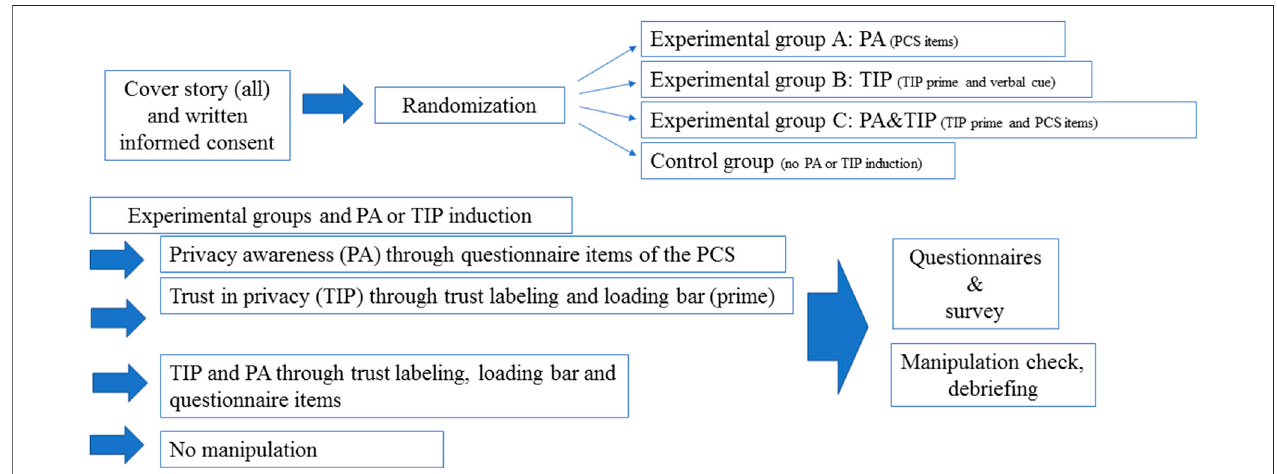
FIGURE 1 | Overview of the study design and sequence of the online study. Note: PA, privacy awareness; TIP, trust in privacy; induction: participants were informed thatdatawould bestored inasafeplaceand aloadingbar wasshowntosimulate datastorage inordertoinducetrust inprivacy;cover story.ForPAinduction participants were shown items from the Privacy Concerns Scale (PCS; Buchanan et al., 2007) in order to induce privacy awareness.